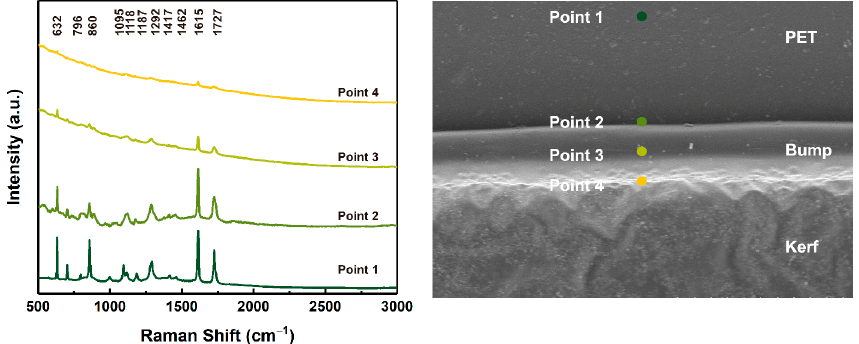
Figure 6. The Raman spectra of PET film after laser processing.